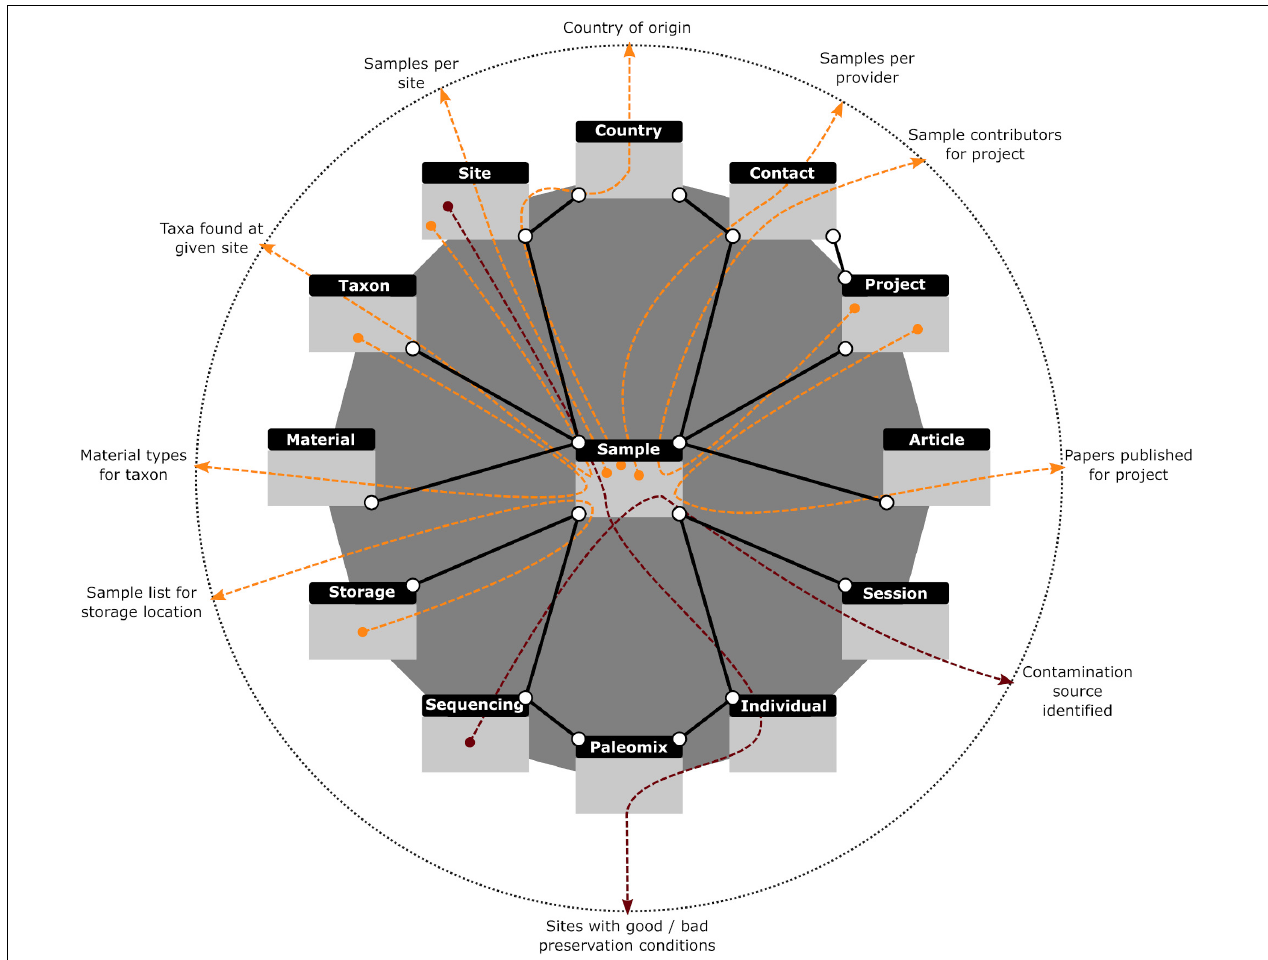
FIGURE 7 | Graphical representation of database queries. Colored arrows (red and orange) demonstrate how different paths through the same connected data sets provide answers to various questions (described at dotted circle). All queries in orange are described in the main text and provided with CASCADE. The red queries illustrate other, less generic queries used to answer very specific questions and hence were not pre-built. Gray rectangles with black headers represent the tables dealing with the data described in each header. Solid black lines represent the relations existing between those data sets. A search query created with our interface first combines the requested data sources (e.g., tables or other previously created queries) based on given criteria, filters the combined data according to user specifications, then selects whatever data fields were requested by the user and returns the result in table